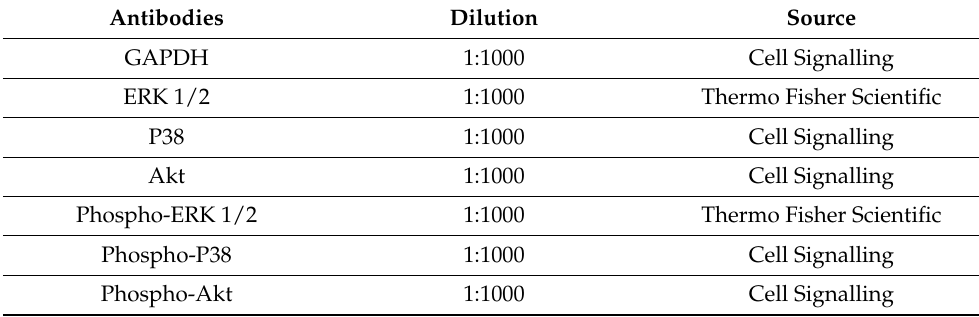
Table 3. List of antibodies used in Western blot. Antibodies Dilution